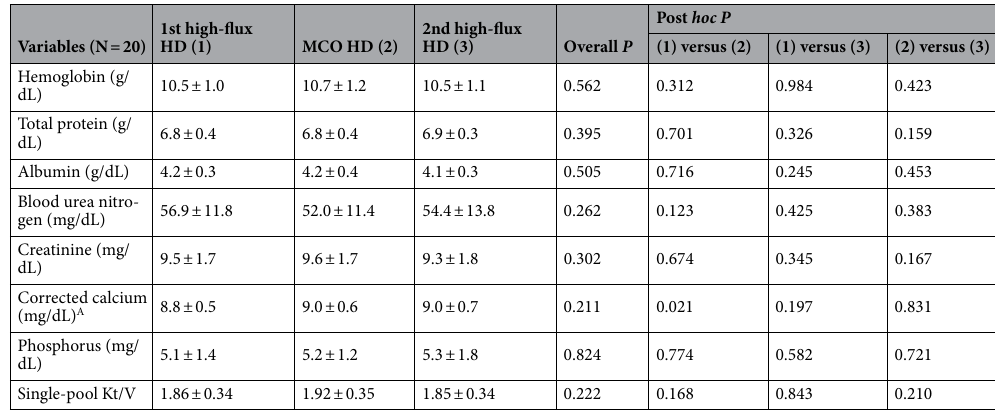
Table 1. Laboratory parameters during each dialyzer period. HD, hemodialysis; MCO, medium cutoff. A Corrected Ca (mg/dL) = measured total Ca (mg/dL) + 0.8 × [4 − measured serum albumin (g/dL)]. P value obtained using repeated measures one-way analysis of variance.